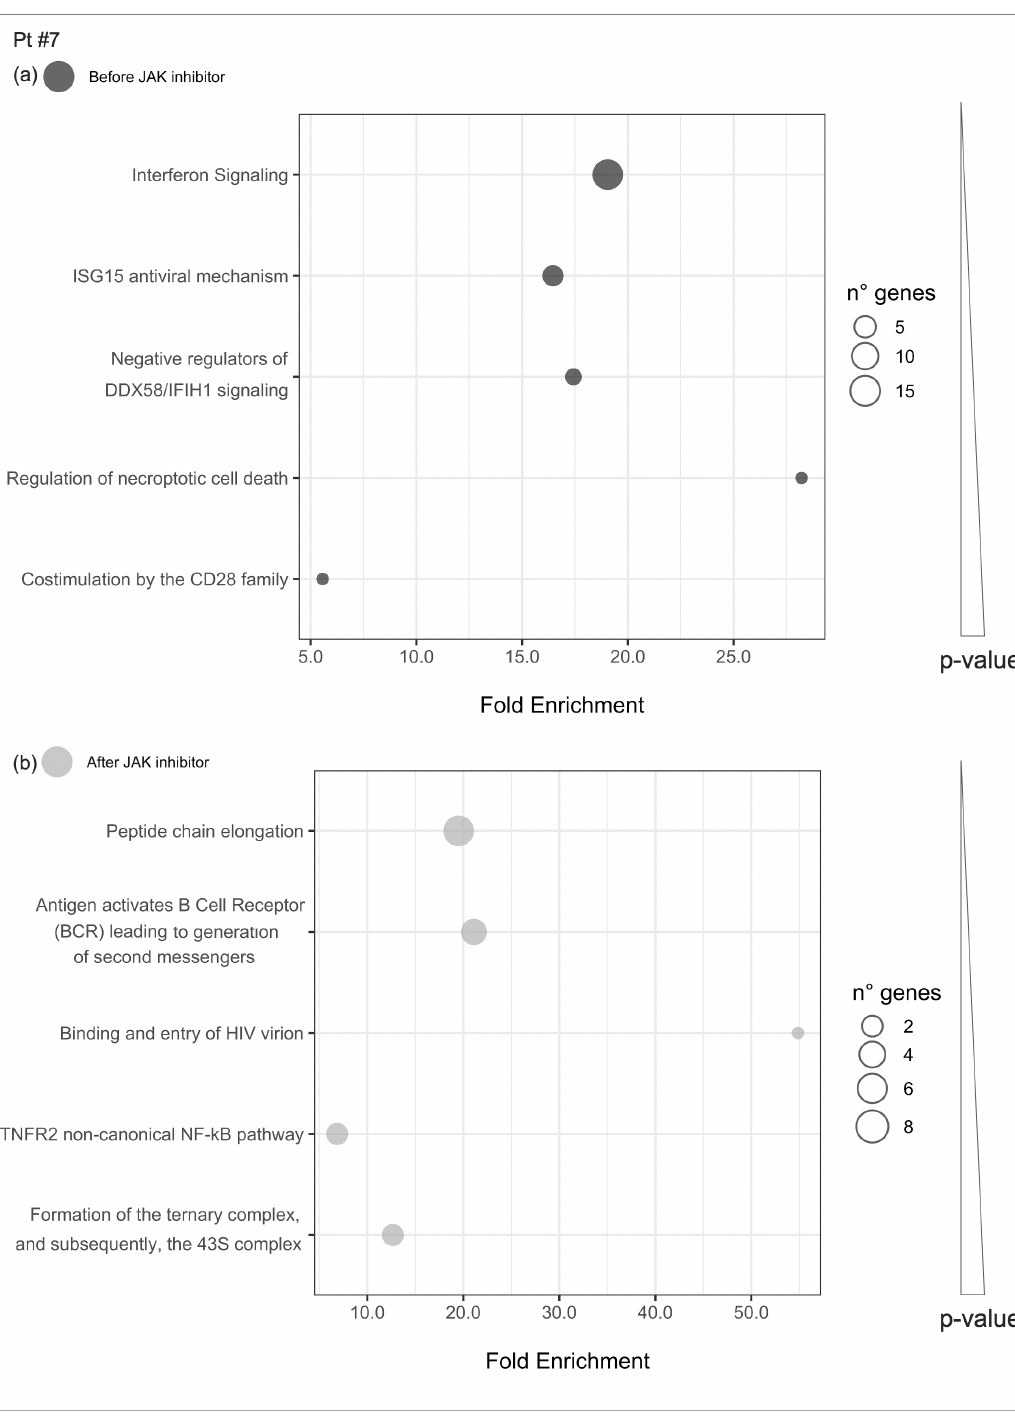
Figure 14. Pathway enrichment analysis was run on di ff erential expressed genes resulting from the comparison between patient #7 before JAKinhibs and the control-group subjects and between patient #7 after JAKinhibs and the controls. Pathways altered uniquely before ( a ) or uniquely after ( b ) JAKinhibs were chosen. Each dot represents a pathway, and the size is directly proportional to the number of genes. On the X -axis the pathway fold enrichment is displayed. All the selected pathways showed a lowest adjusted p -value of the given term over all iterations ≤ 0.01, and the five most enriched pathways were elected, where applicable. Pathways are ordered by increasing p -values. Pathways altered before JAKinhibs are colored in dark grey and those altered after JAKinhibs in light